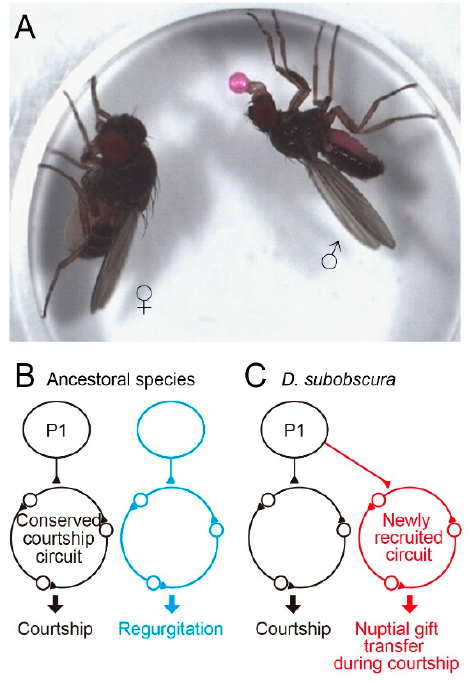
Figure 3. A possible circuit mechanism whereby D. subobscura acquired the novel courtship action element nuptial gift. ( A ) Nuptial gift transfer. ( B ) The regurgitation circuit operating independent of the courtship circuit in the ancestral state. ( C ) The regurgitation circuit neurons in toto happened to express the courtship master gene fruitless , resulting in the incorporation of this circuit into the courtship neural network in D. subobscura .